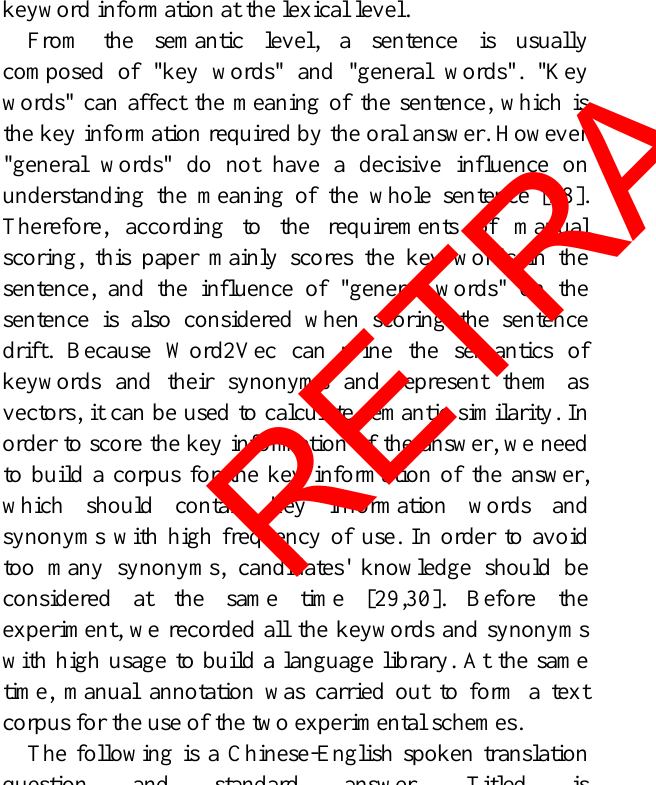
Figure 2. Flow chart of lexical semantic